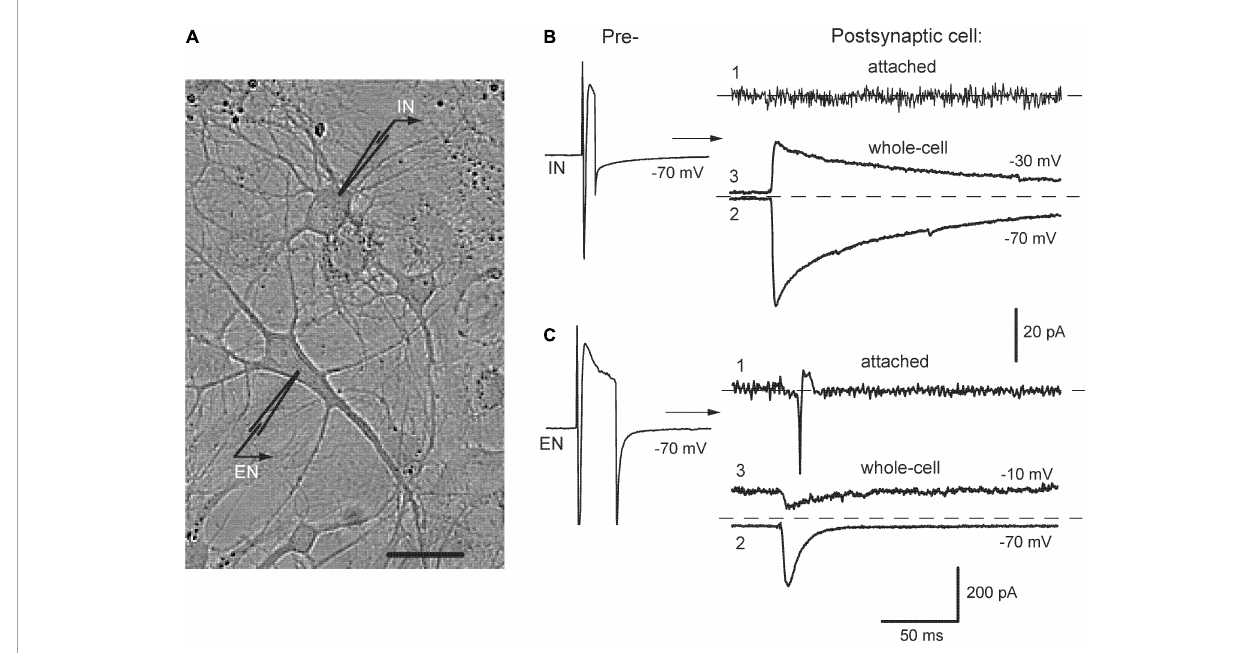
FIGURE1 Identification of neurons in pair recordings. (A) A photograph of mutually connected inhibitory-excitatory neurons (IN-EN pair) in culture, bar 20 µ m. (B,C) Left , stimulation of presynaptic cells to evoke inward Na + currents. Right , respective postsynaptic responses recorded consecutively in cell-attached (1) and whole-cell mode at indicated membrane potentials (2, 3). From here on, such values are designated near the